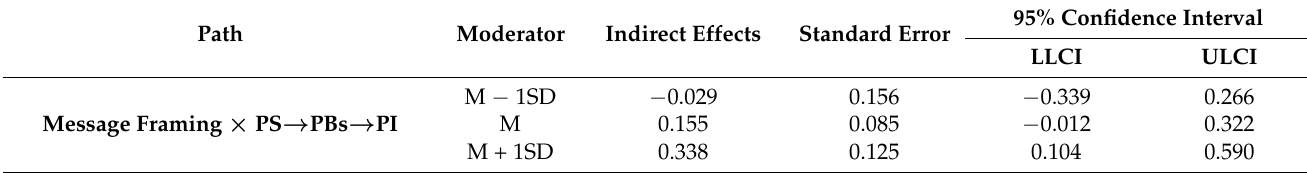
Table 7. Results of the test of moderated mediating